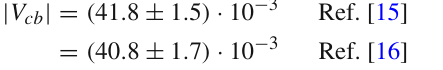
to the second [16] set of the Belle measurements. The dashed blue (red) bands are the results of Eqs. (4)–(5) in the case of the blue squares (red circles) for each variable x (see Refs. [15,16] for the specific values of the four variables x in each bin)